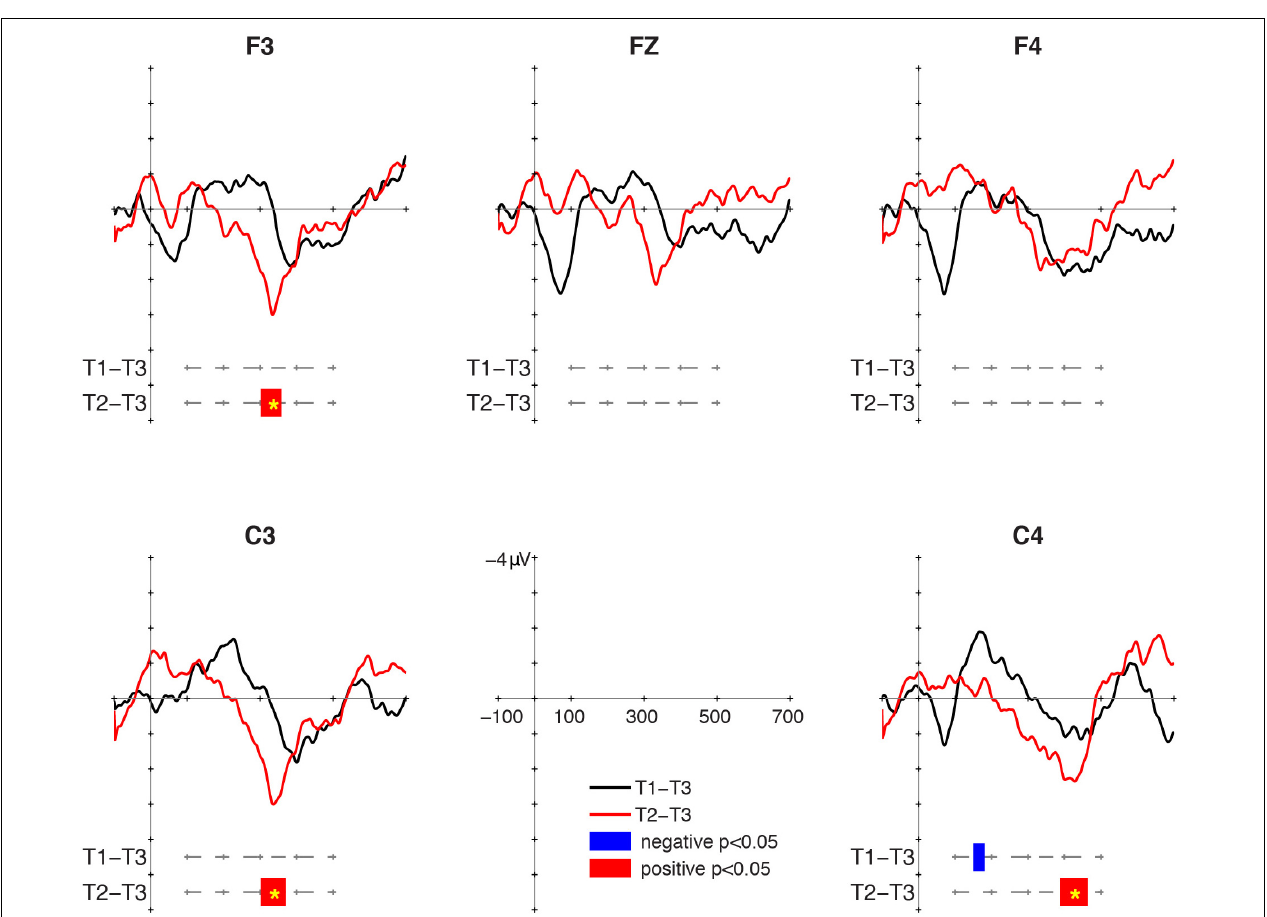
FIGURE 1 | Mismatch responses (MMRs) at 12 months of age. Black lines display the difference wave for the large deviant (LD-S, T1-T3), and red lines display the difference wave for the small deviant (SD-S. T2-T3). Blue bars mark negative clusters, and red bars mark positive clusters in the paired t -test. Asterisks in the bars mark those clusters significant in the cluster-based